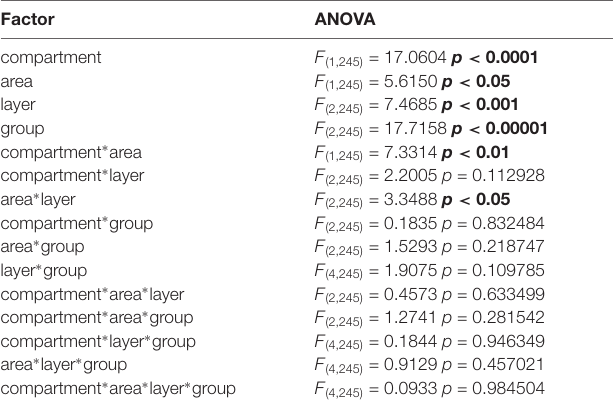
TABLE 3 | Summary of the results of multifactorial ANOVA that was conducted for the factors: area (35,36), group (control, micro, macro), compartment (middle, caudal), and layer (II, III,